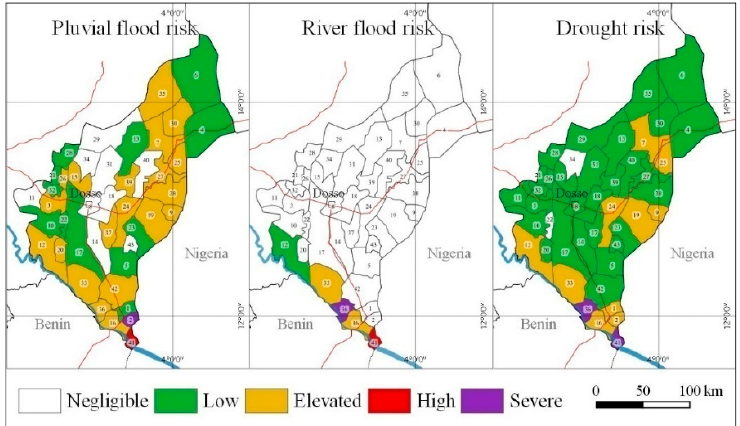
Figure 11. Pluvial flood ( left ), fluvial flood ( center ), and drought ( right ) risk levels from 2011 to 2017 in the Dosso region using data from Table 4.